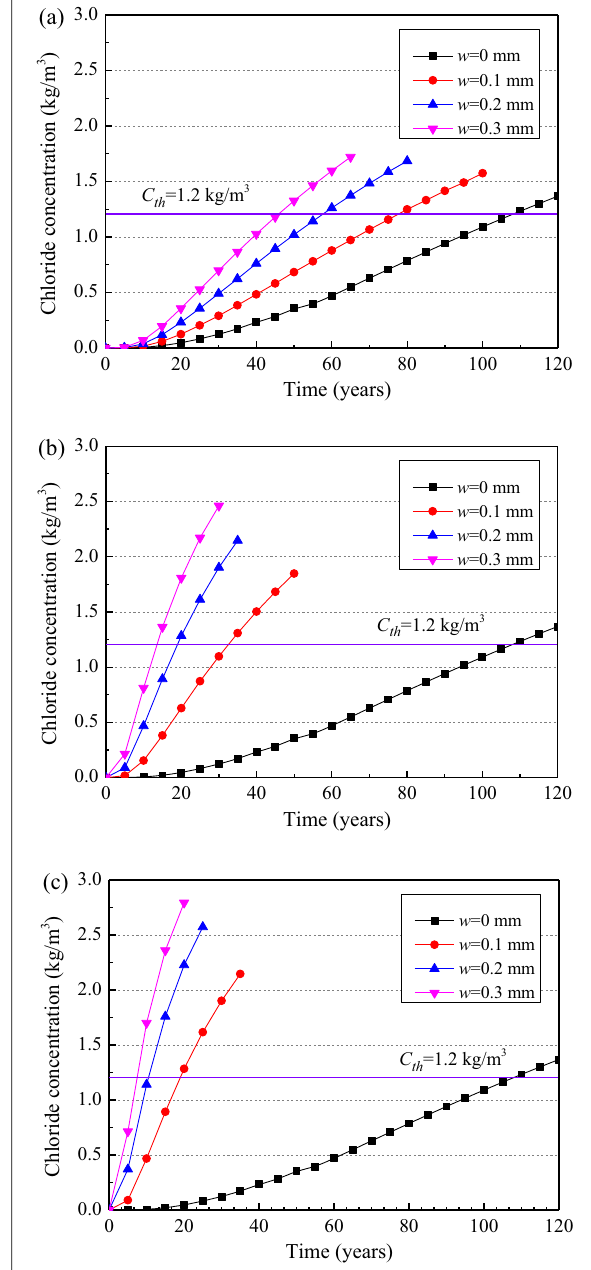
Fig. 6 Variations of chloride concentration at the depth of reinforcement with exposure time for different number of cracks: a n 1, b n 5 and c n = = =